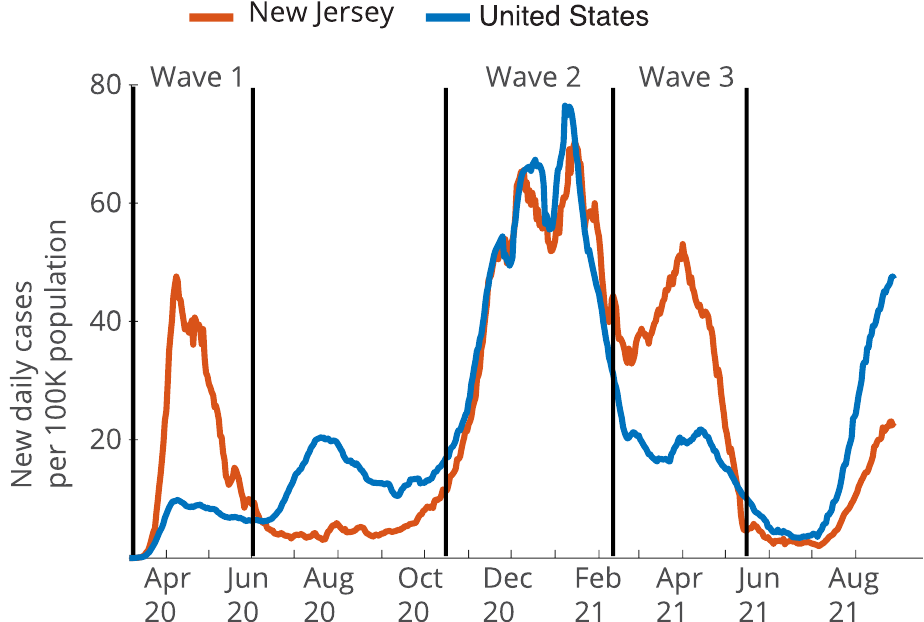
Figure 1. New daily COVID-19 cases per 100k population in New Jersey and the United States. Notes: Data were obtained from the COVID-19 Data Repository by the Center for Systems Science and Engineering (CSSE) at Johns Hopkins University. The plot was created from the raw data files by dividing new daily cases by population and then smoothing over a 7-day